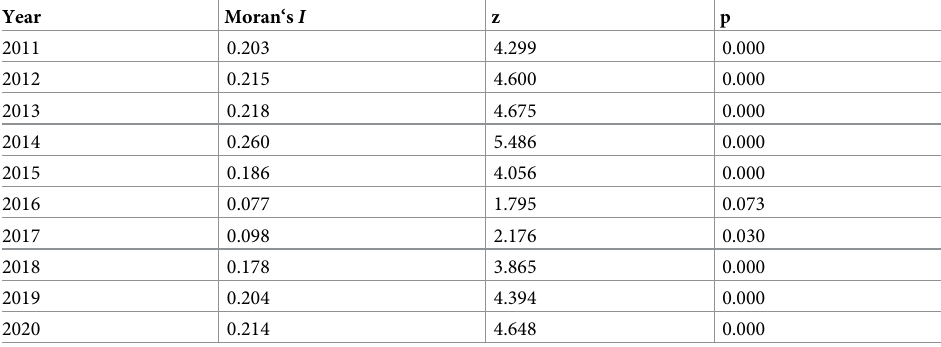
Table 3. The result of global spatial autocorrelation analysis of new detected leprosy cases in Yunnan, China 2011–2020.